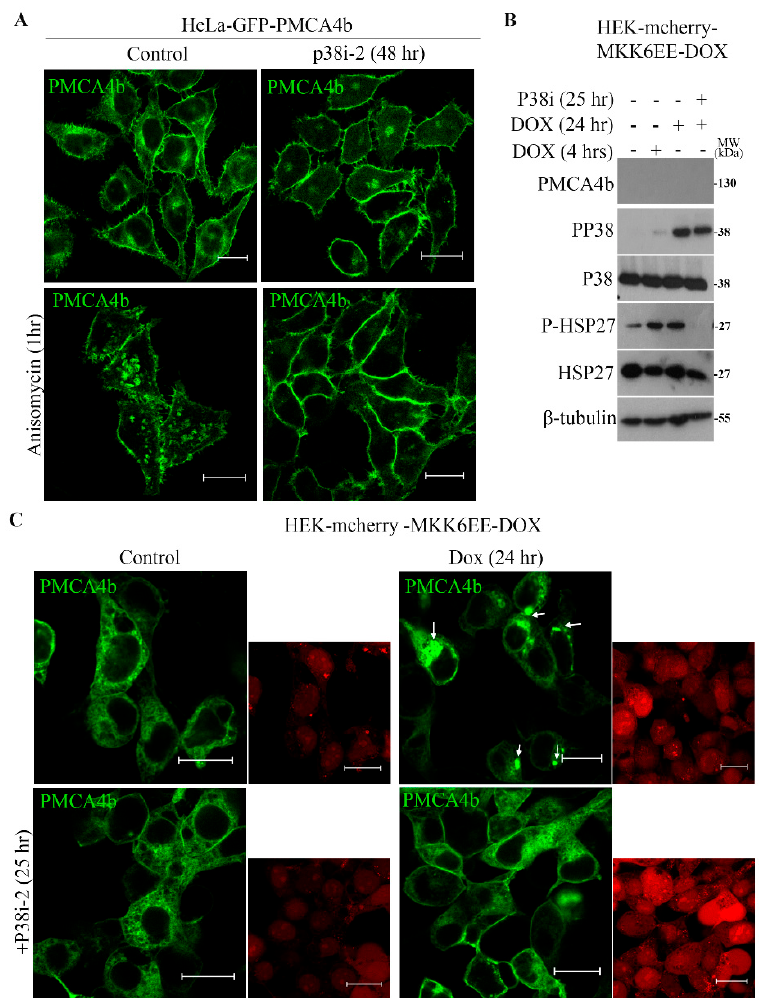
Figure 4. Activation of P38 MAPK induced GFP-PMCA4b internalization in the BRAF wild type HeLa cells and in a non-tumorigenic doxycycline inducible HEK-mCherry-MKK6 cell model system. ( A ) Confocal microscopy images of Hela-cells stably expressing GFP-PMCA4b treated with 10 µ M of p38i-2 inhibitor SB202190 for 48 h or 2.7 µ g / mL anisomycin for 1 h, and in combination. Scale bar, 20 µ m. ( B ) HEK-mCherry-MKK6EE-Dox inducible cells were seeded in 6 well plate and after 24 h 10 µ M p38i-2 inhibitor SB202190 was added and incubated for a total of 25 h. During the p38i-2 inhibitor treatment 2 µ g / mL doxycycline was added to the media so that MKK6 was induced for 4 or 24 h, respectively. Protein expression was analyzed by western blotting. ( C ) Confocal microscopy images of HEK-mCherry-MKK6EE-Dox cells transiently transfected with the SB-CAG-GFP-PMCA4b-CAG-Puro plasmid DNA construct for 24 h. After transfection, the cells were incubated with 10 µ M of p38i-2 for 25 h. To induce MKK6, 2 µ g / mL doxycycline was added 1 h after p38i-2 and incubation was followed for an additional 24 h. Arrowheads show GFP-PMCA4b positive vesicles, the images on the side show mCherry signal for the same cells, Scale bar, 20 µm.